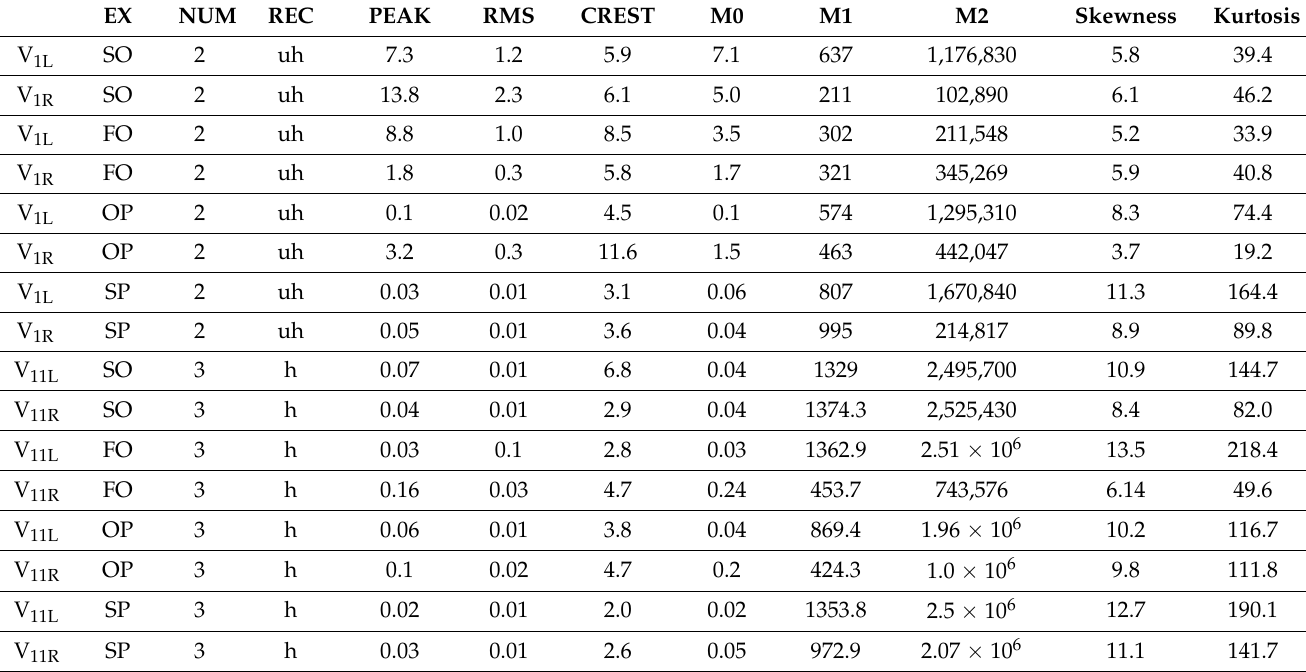
Table 2. Examples of vibrational signal features vector.